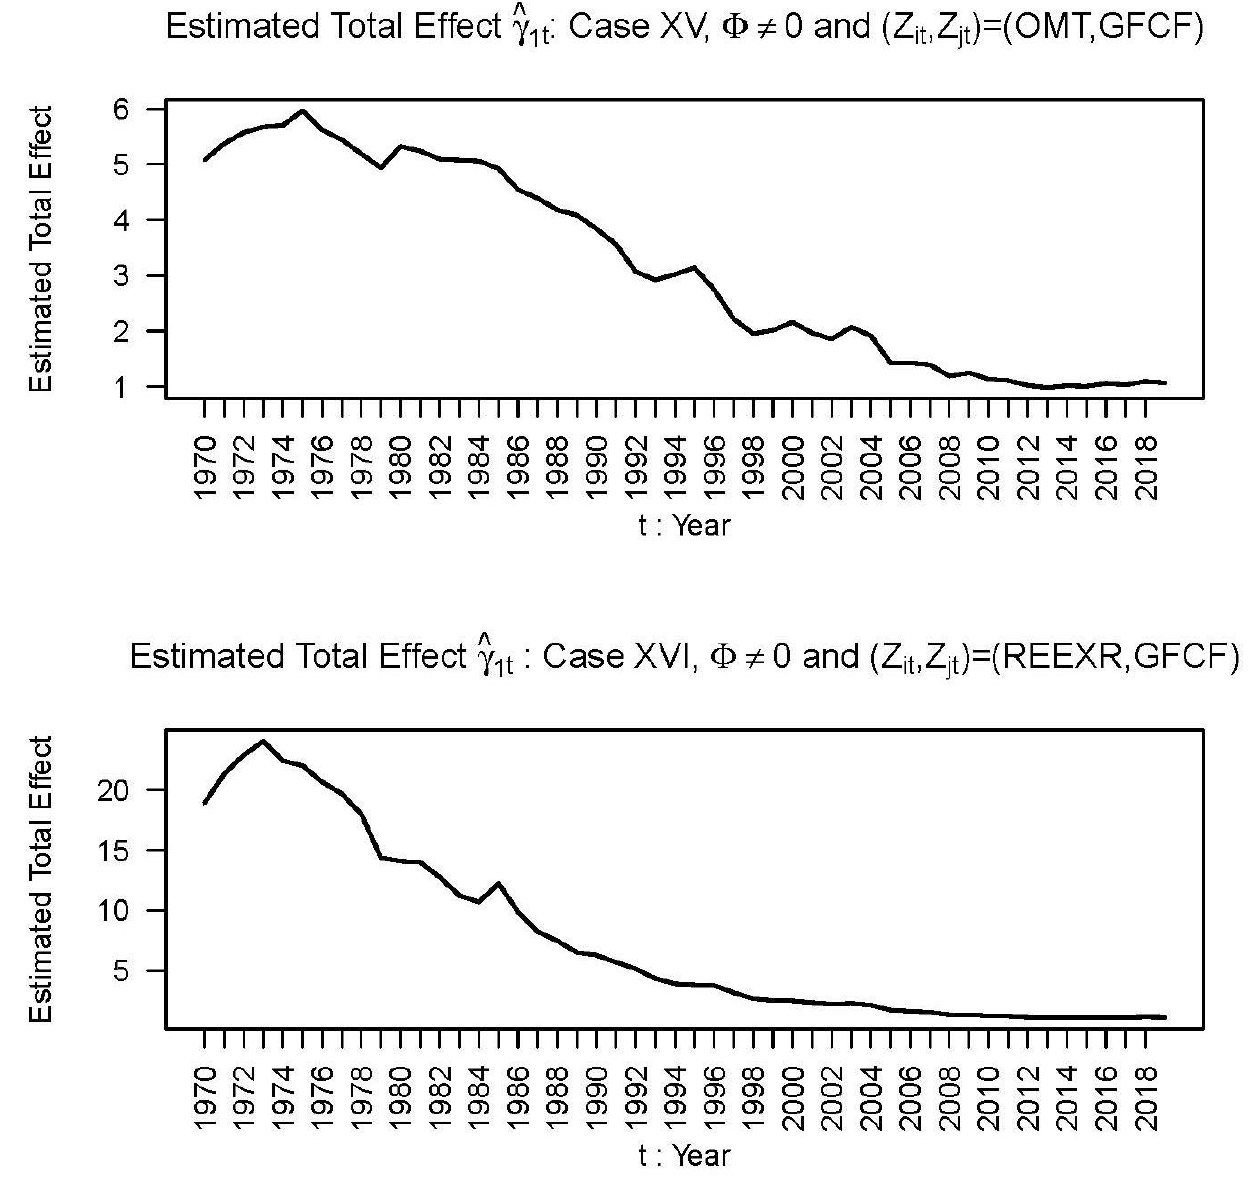
Figure 2. Plot of the estimated total effects of CBC on RGDP in different years.